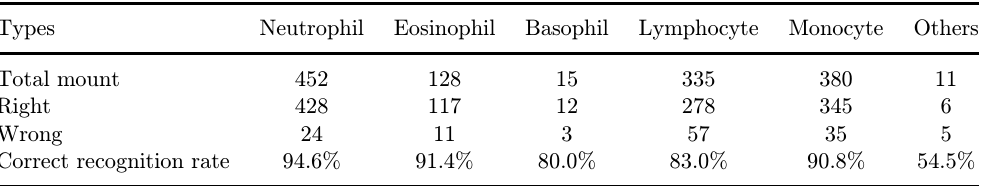
Table 5. Recognition rate with geometric and color features.